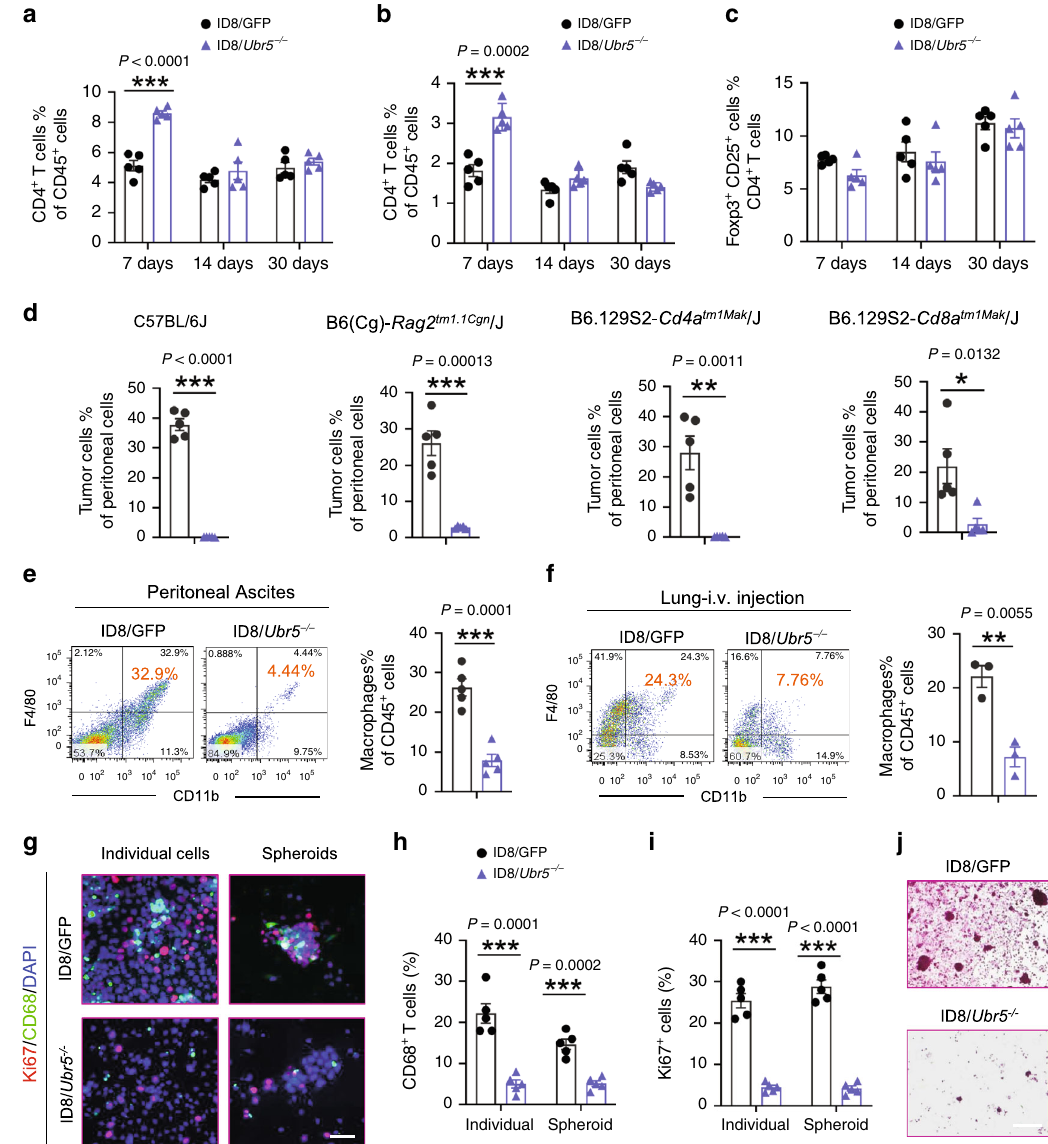
Fig. 2 Analysis of immune cell involvement in regulating ID8/ Ubr5 − / − tumor growth. a – c Peritoneal washes were collected at indicated times from OC bearing mice after peritoneal implantation of ID8 cells ( n = 5 mice per group). CD4 + ( a ) /CD8 + ( b ) T cells were analyzed on CD45 + in fi ltrating cells. c Foxp3 + CD25 + regulatory T cells were analyzed on CD45 + CD3 + CD4 + tumor in fi ltrating T cells (TILs). d B and T cell de fi ciency did not mitigate the differences in growth capacity between control and Ubr5 − / − tumors. Proportion of Muc16 + CD45 − tumor cells in ascites were quanti fi ed at day 30 post OC implantation ( n = 5 mice per group). e , f Representative FACS images of in fi ltrated CD11b + F4/80 + macrophages in peritoneal cavity or lung at day 30 after tumor injection. Proportion of macrophages on CD45 + in fi ltrating cells in peritoneal cavity ( e ) ( n = 5 mice per group), and lung ( f ) ( n = 3 mice per group) were quanti fi ed. g Representative images of CD68 + macrophages and surrounded Ki67 + cells. All panels are the same magni fi cation, scale bars: 50 μ m. h – i CD68 + cells ( h ) and Ki67 + cells ( i ) in individual and spheroid populations were quanti fi ed ( n = 5 mice per group and ten confocal images acquired from each sample). j At day 30 post i.p . injection, spheroids from peritoneal washes were harvested and evaluated by H&E staining ( n = 5 mice per group and an average of 10 fi elds acquired from each sample). Scale bars: 200 μ m. In all cases, data are representative of at least two independent experiments with similar results. Data are presented as mean ± SEM, unpaired two-sided Student ’ s t -test with no correction for multiple comparison, * P < 0.05, ** P < 0.01, *** P < 0.001. Source data are provided as a Source Data fi compared to TAMs from WT tumor-bearing mice, those from bearing mice displayed strongly reduced levels of intracellular Ubr5 − / − tumor-bearing mice exhibited higher levels of M1 mac- arginase-1 (Fig. 4c) and surface PD-L1 (Fig. 4d) expression in rophage markers (e.g., il12a, Ccr2 ) and lower levels of M2 markers comparison with TAMs from ID8/GFP bearing mice. Although (e.g., Cx3cr1, il10 ) (Fig. 4b and Supplementary Fig. 6b). Strikingly, TAMs from both hosts were comparable in their ability to stimulate expression of Cx3cr1 , which is increased during monocyte ID8 tumor migration (Supplementary Fig. 6c – e), TAMs from ID8/ maturation and inversely correlated with CCR2 in the blood 24 , was Ubr5 -/- tumor-bearing mice exhibited weaker T cell proliferation- markedly induced in TAMs from WT tumor-bearing mice while inhibiting activities than those from ID8/GFP tumor bearing mice totally inhibited in the absence of UBR5. TAMs from ID8/ Ubr5 − / − (Fig. 4e), suggesting that tumor-derived UBR5 not only affects